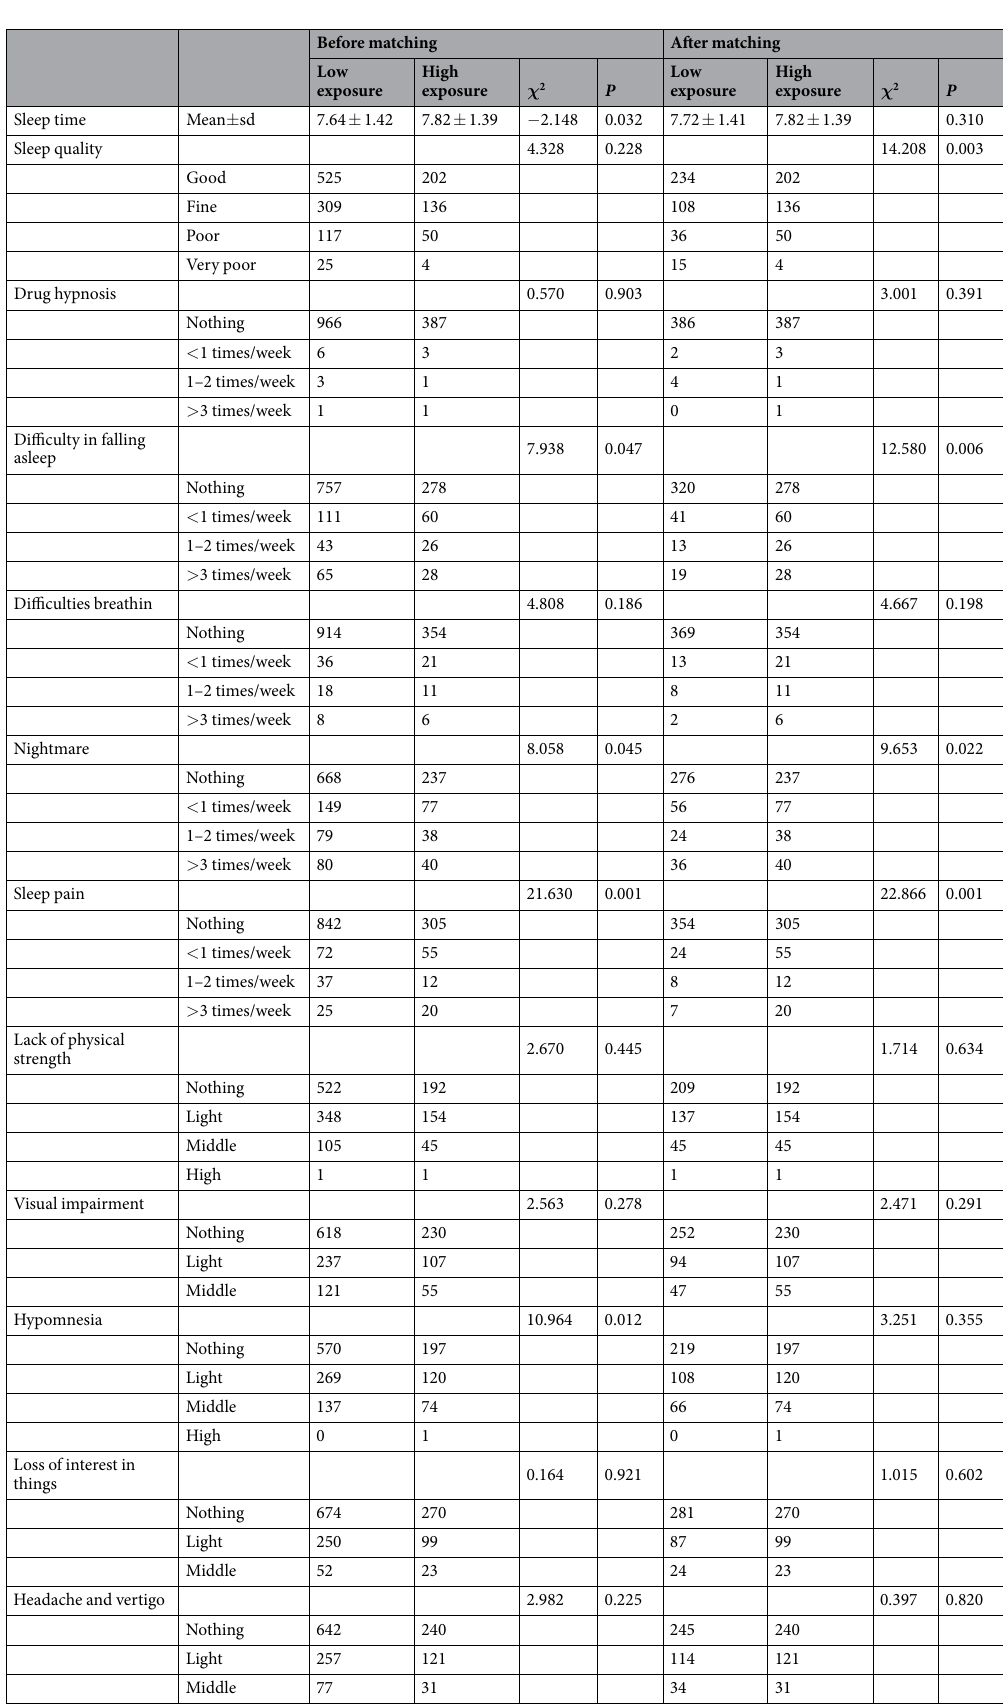
Table 6. Difference Test of Symptom Frequency in nervous system before and after